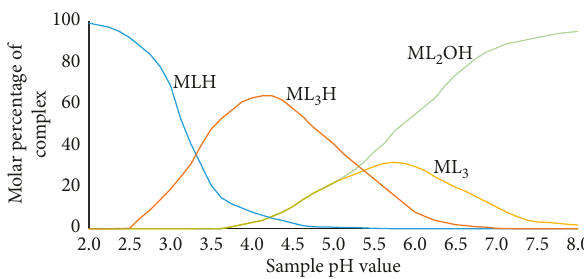
Figure 2: The types of complexes Al 3+ -ECR depending on solution pH, μ 0.1 M KNO 3 (cid:30)